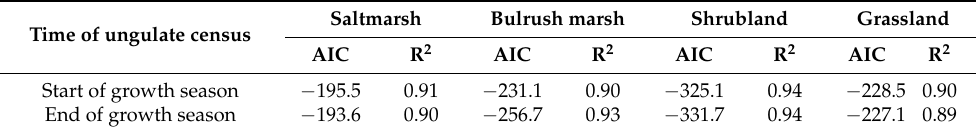
Table 2. Summary table for the comparison between models based on ungulate censuses before or after the plant’s growth season. Bold type indicates significantly better fits ( ∆ AIC > 2).